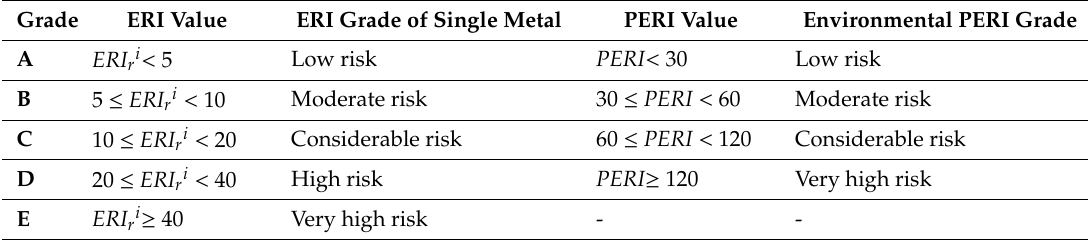
Table 4. Grades of the ecological (ERI) and potential ecological risk index (PERI)